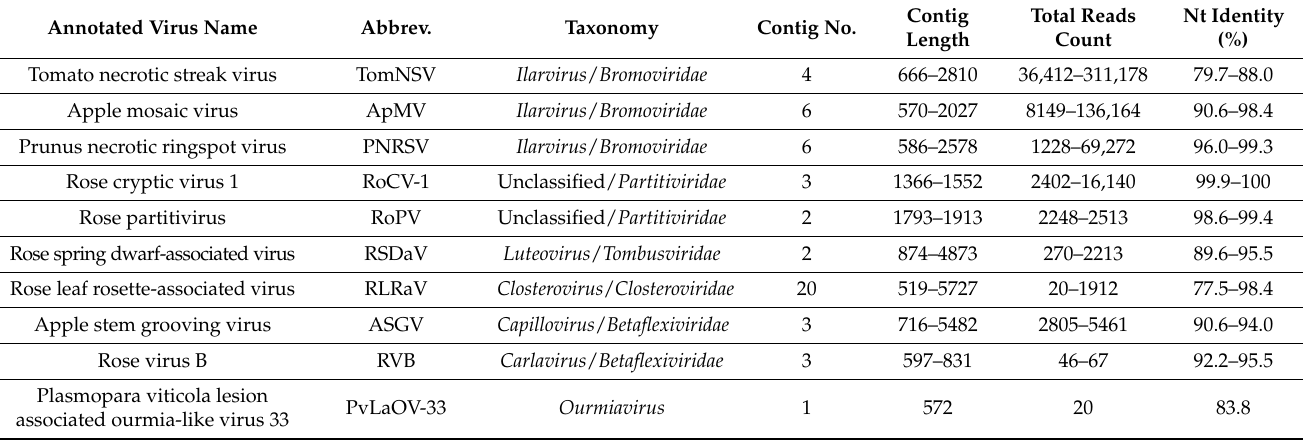
Table 1. The annotation result of the contigs de novo assembled from high-throughput sequencing